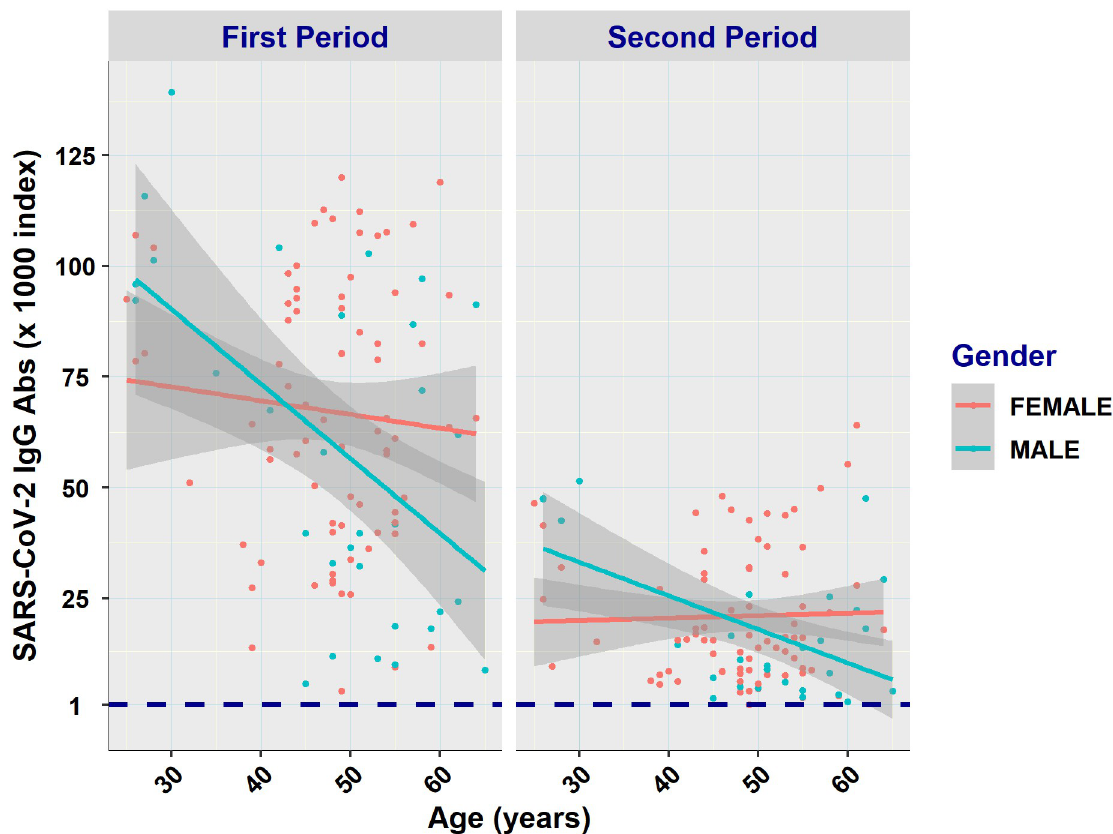
Fig 2. Least squares trend lines of SARS-CoV-2 antibody titers vs . age of females and males for each sampling period. The subset of subjects tested in both study periods (n = 110) was included here. Titers higher than three times the IQR were excluded as extreme outliers. Shaded areas represent 95% CIs. Approximately three months post vaccination, a trend of constant decline for males and a stabilizing process for females are evident. The coefficients of determination of each regression line were as follows: First period: Male R 2 = 0.2767, Female R 2 = 0.0071; Second period: Male R 2 = 0.2894, Female R 2 = 0.0001. In both periods females showed a consistent rate not differing from